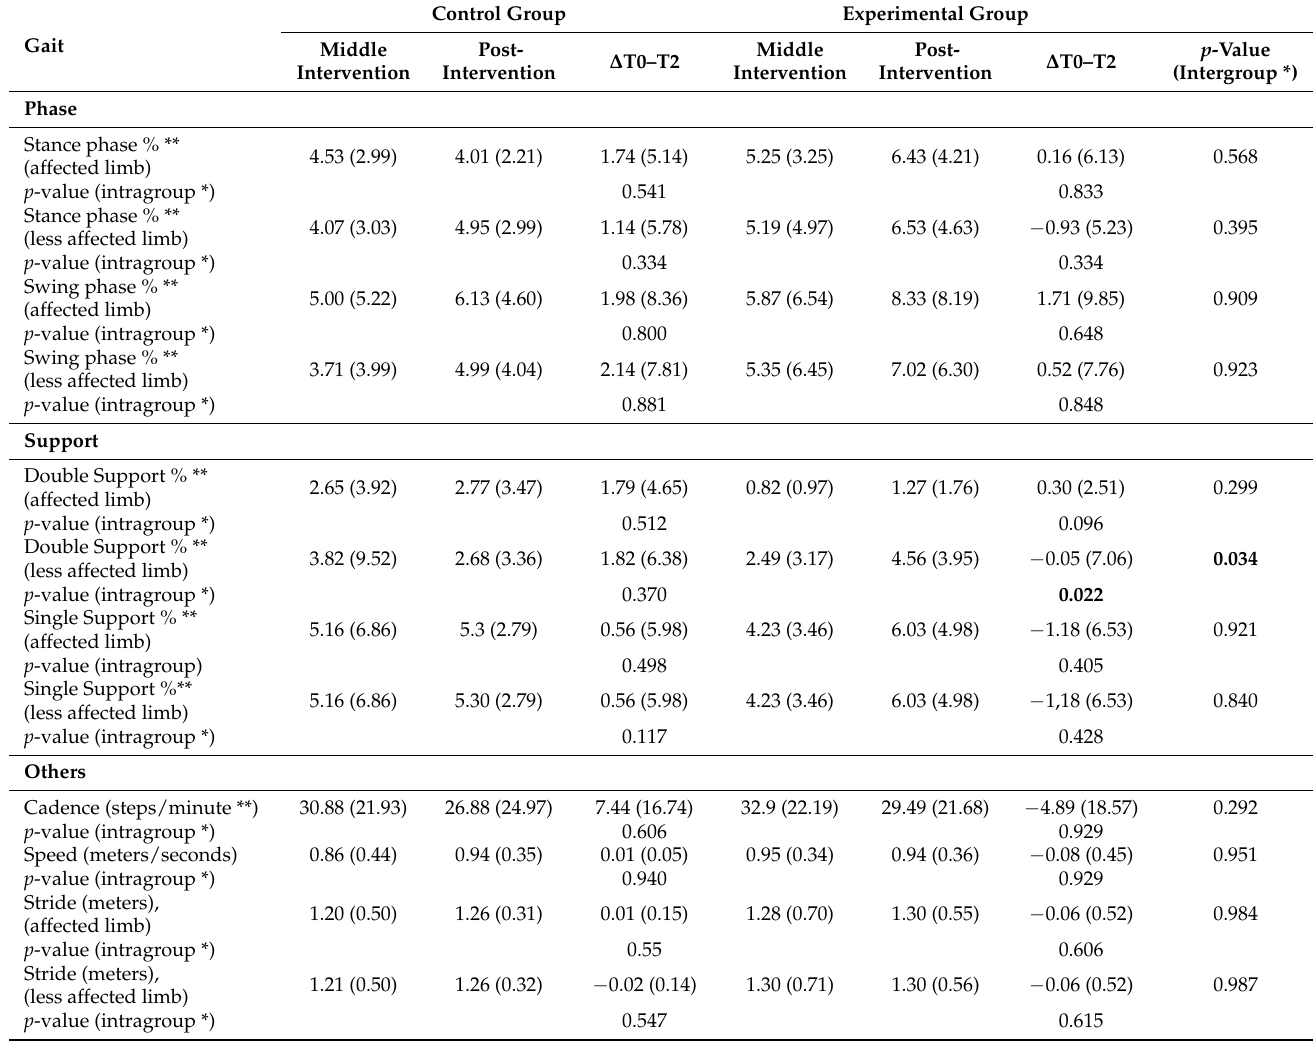
Table 4. Gait analysis middle and post-intervention.